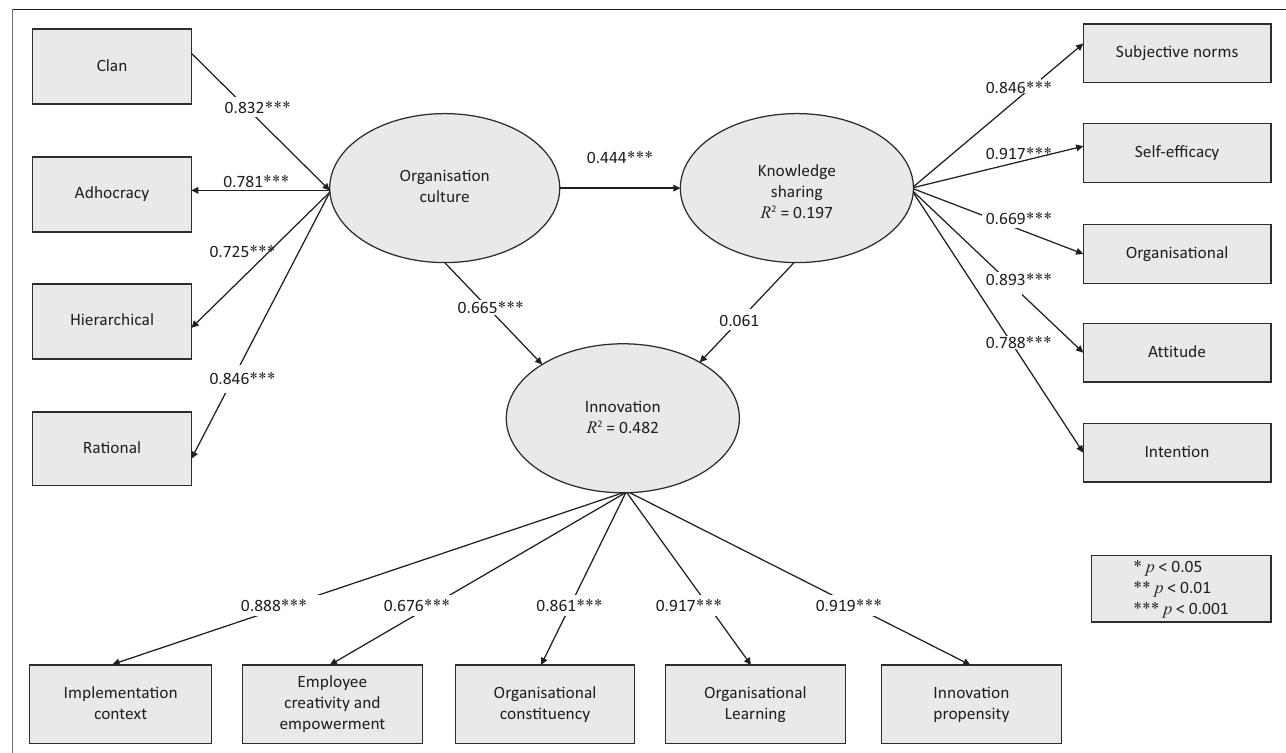
FIG URE 3: The structural equation model of organisational culture, knowledge sharing and